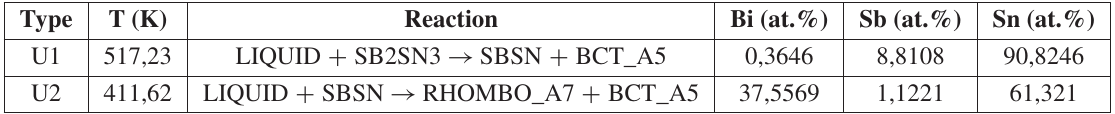
Table 5. Invariant reactions of ternary Bi-Sb-Sn system.